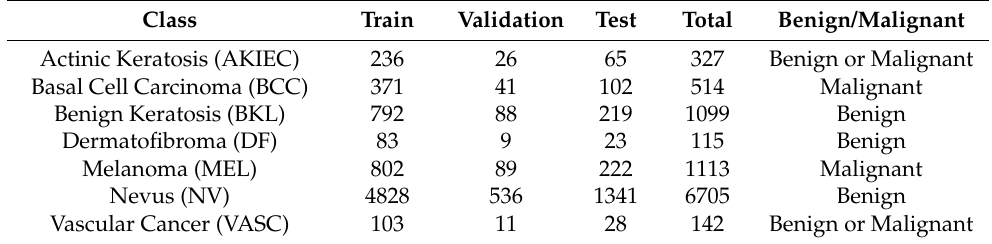
Table 1. Dataset statistics.